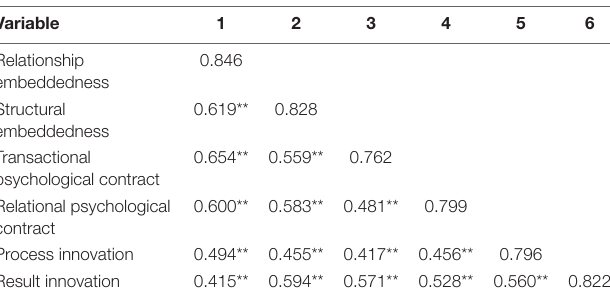
TABLE 3 | Correlations and square root of AVE